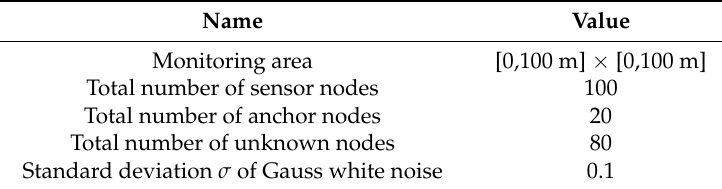
Table 4. Parameter table for influence analysis of maximum communication